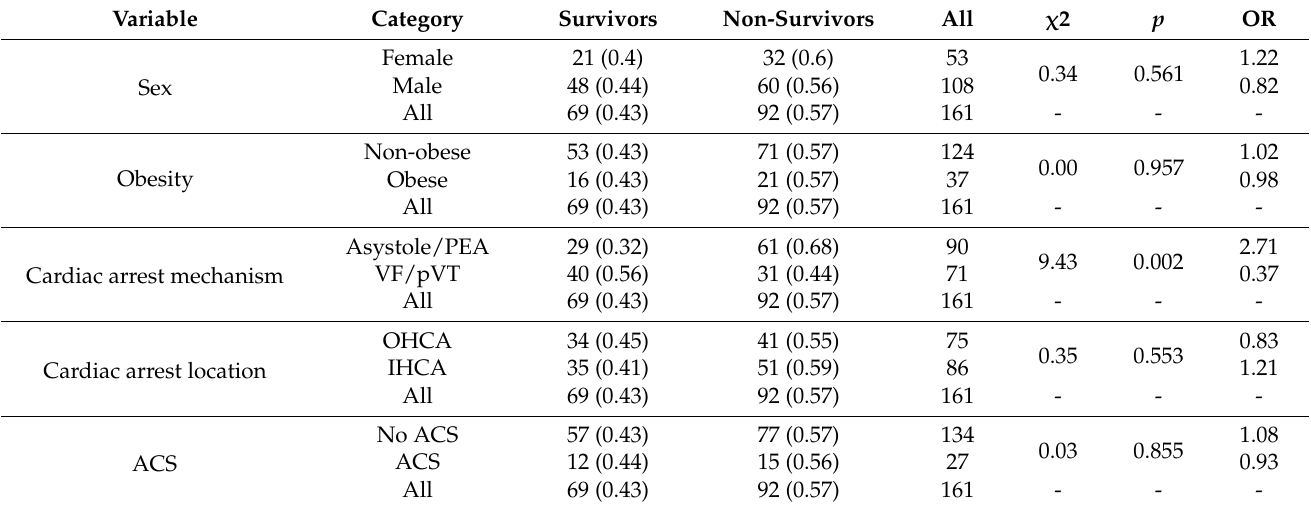
Table 5. Differences between non-survivors and survivors (categorical